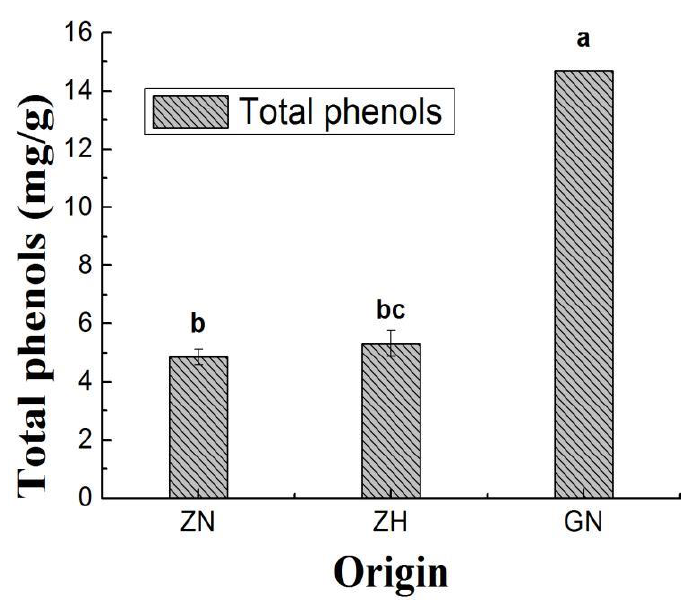
Figure 2. Total phenol contents of K. obovata seedlings. Different letters indicate significant difference among sources at the same sampling time according to one-way ANOVA at P < 0.05. GN: normal leaves from Zhanjiang, Guangdong; ZH: the half-wilted leaves from Zhoushan, Zhejiang; ZN: the normal leaves from Zhoushan, Zhejiang.